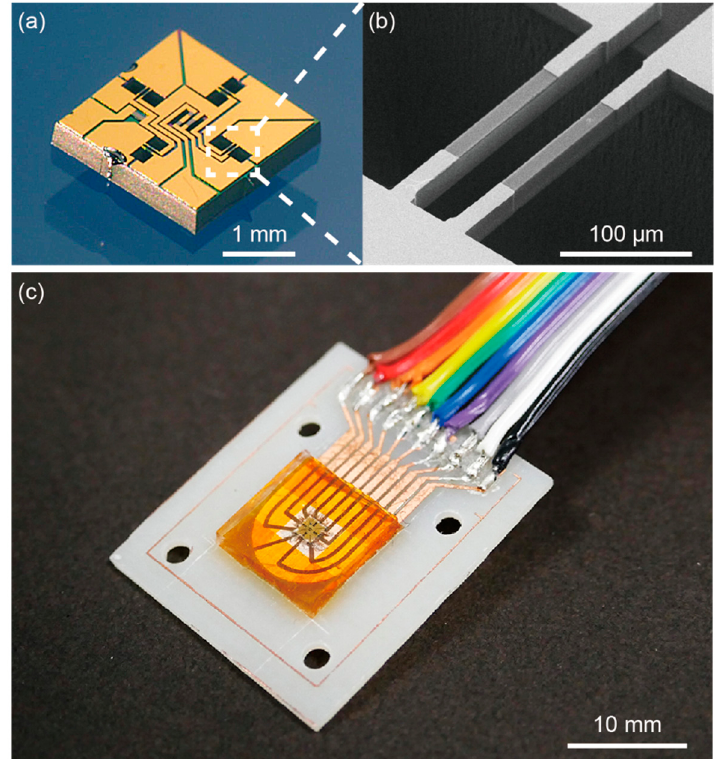
Figure 6. ( a ) Photograph of the sensor chip; ( b ) SEM image of the beams; ( c ) Photograph of the prototype of the proposed sensor.